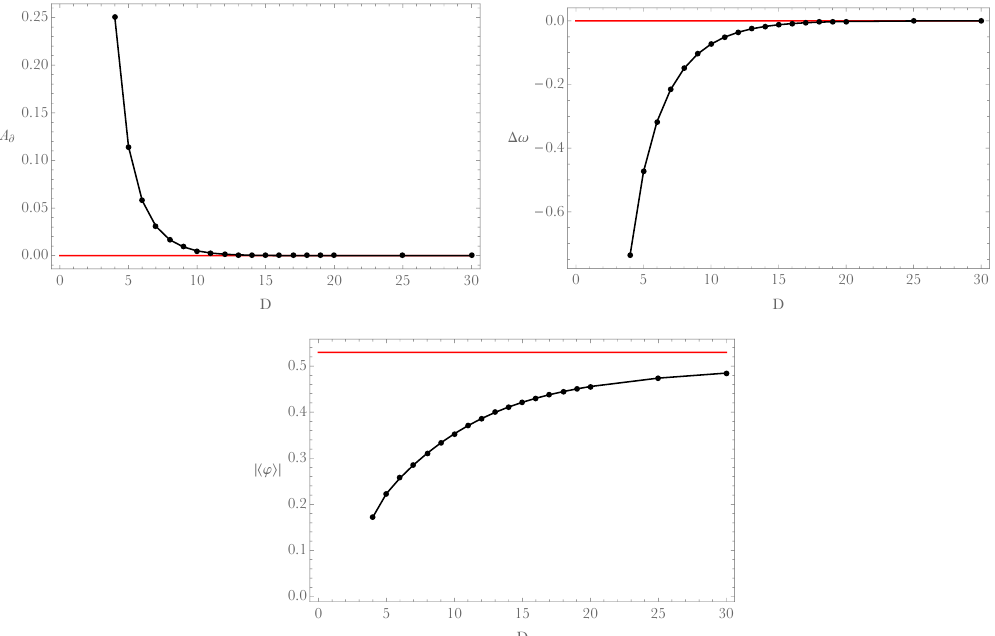
Figure 3 . Comparison of stars at (cid:12)nite D (black dots) to those from the leading order large D limit (red line). All solutions